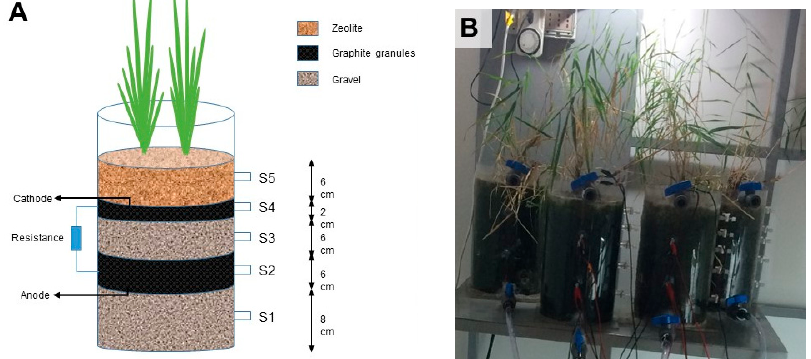
Figure 1. Constructed wetland-microbial fuel cell (CW-MFC) built using P. australis . ( A ) Diagram of the reactor, where S1, S2, S3, S4, and S5 are sampling ports located in each layer; ( B ) Photograph of the four reactors.